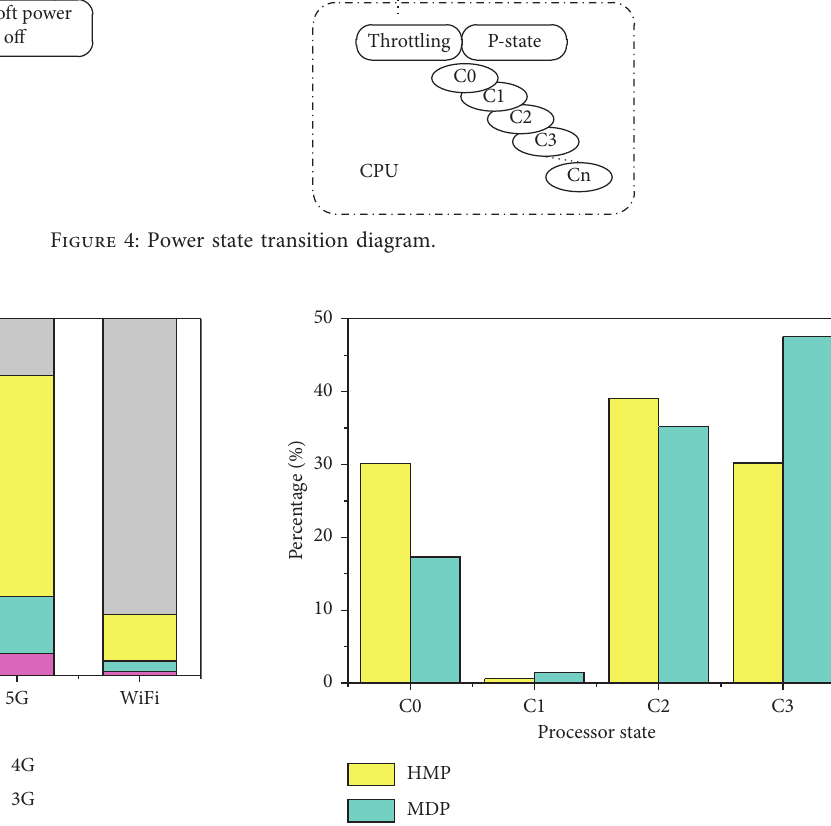
Figure 6: Percentage of the four processor states under the HMP and MDP optimization strategies.